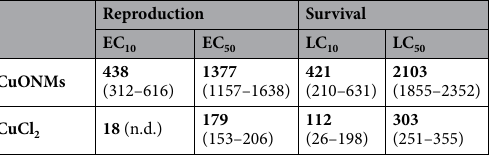
Table 2. Estimated effect concentration (EC) values for the Enchytraeid Reproduction Test (ERT) performed with Enchytraeus crypticus when exposed to CuONMs and CuCl 2 in LUFA 2.2 soil. Confidence intervals are shown in brackets. n.d.: not determined.